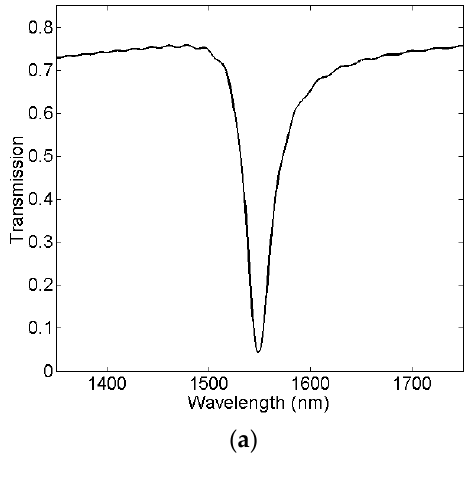
Figure 4. Cont. Figure 4. Cont.